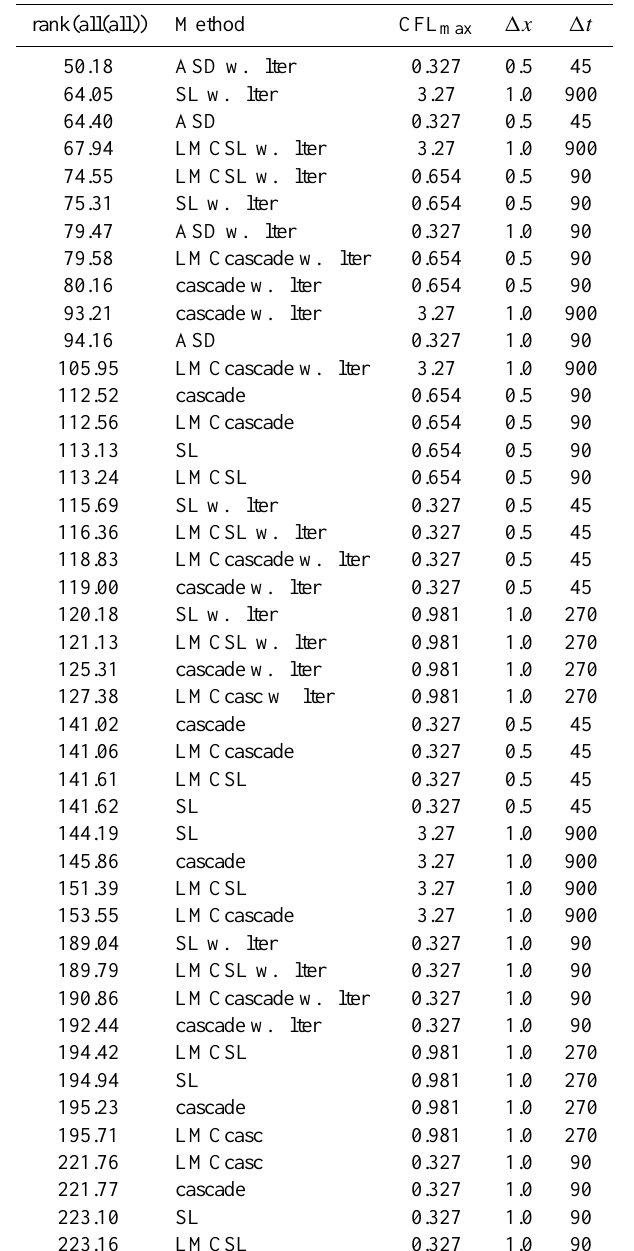
Table 7. Ranking results for the sum of rank(all) from all six ranking tables. Showing the sum of the total rank, rank(all(all)), method, maximum courant number, grid size, and time